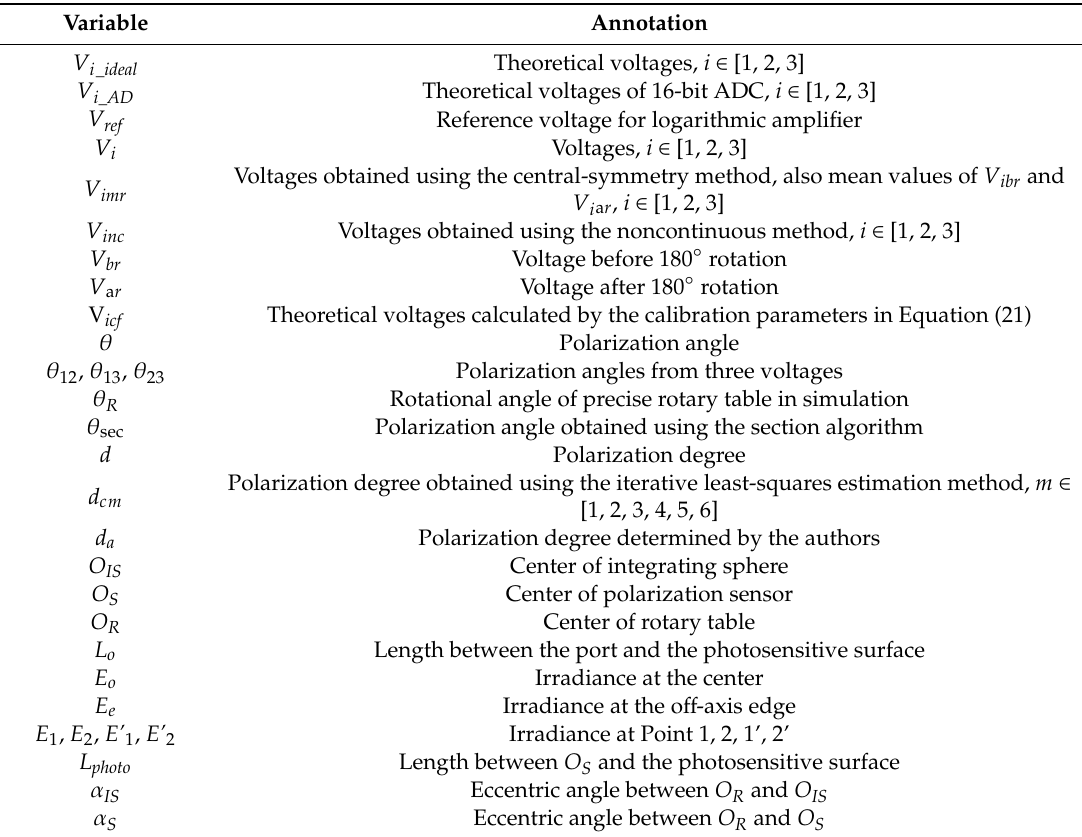
Table 1. Mathematical